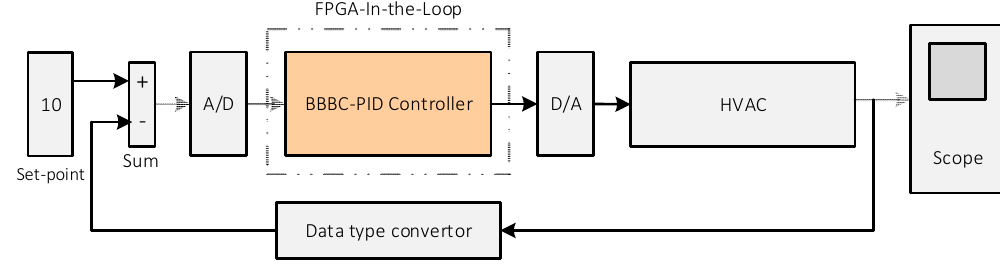
Figure 9. Block diagram of our MATLAB/Simulink model.